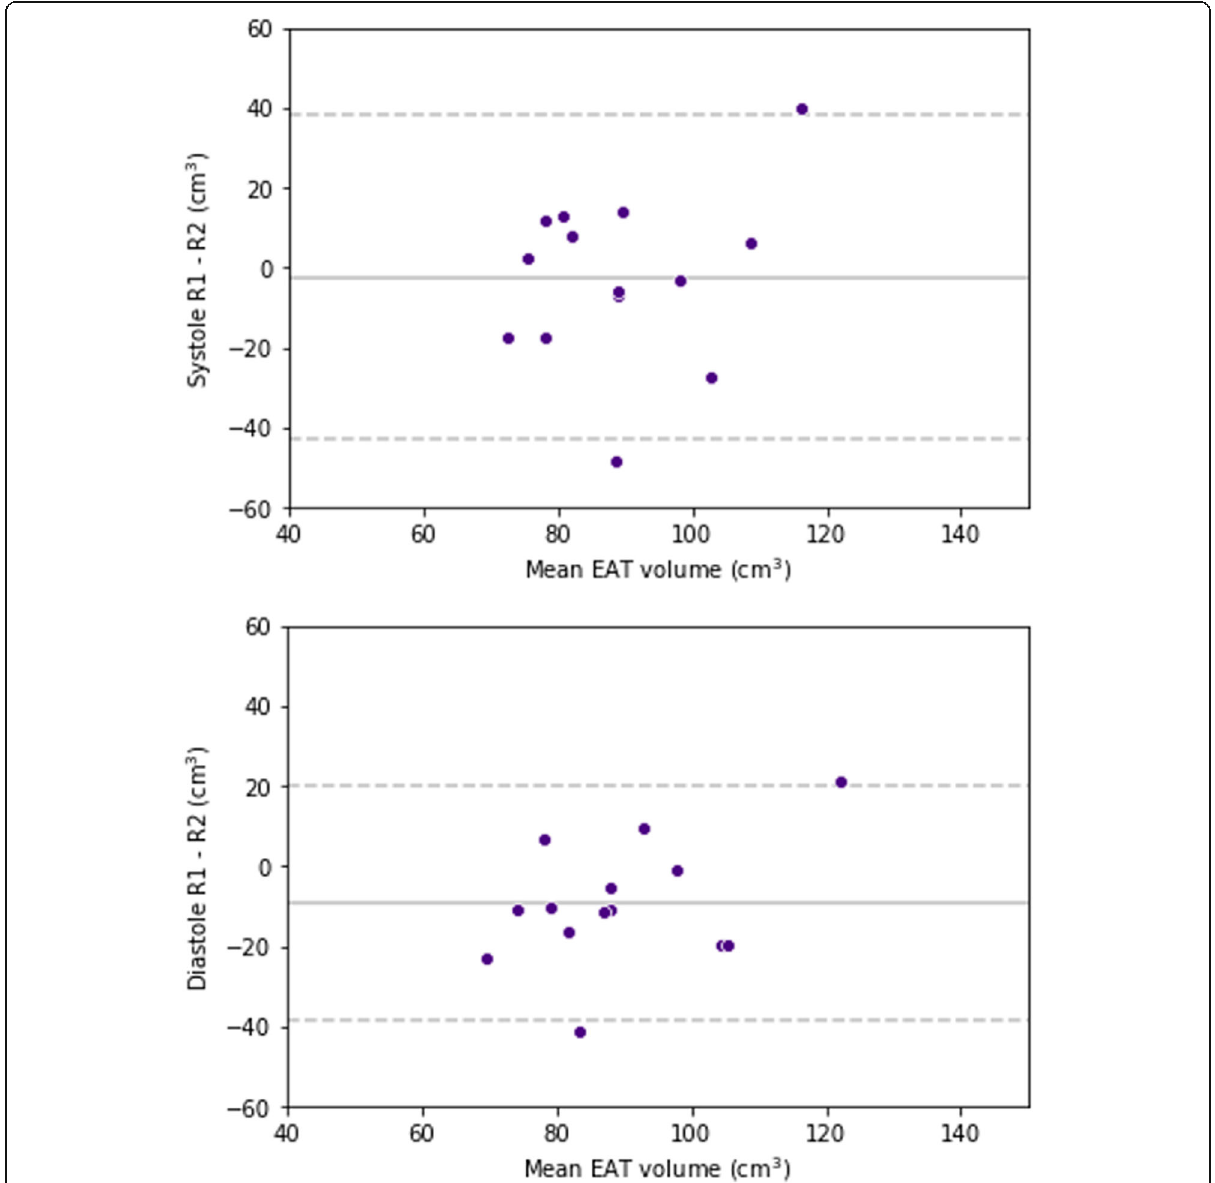
Fig. 3 Bland-Altman plots for inter-reader reproducibility of epicardial adipose tissue volume at systole and diastole. Dashed lines represent 95% confidence intervals and are placed at ± 2 standard deviations. EAT, Epicardial adipose tissue; R1, Reader 1; R2, Reader